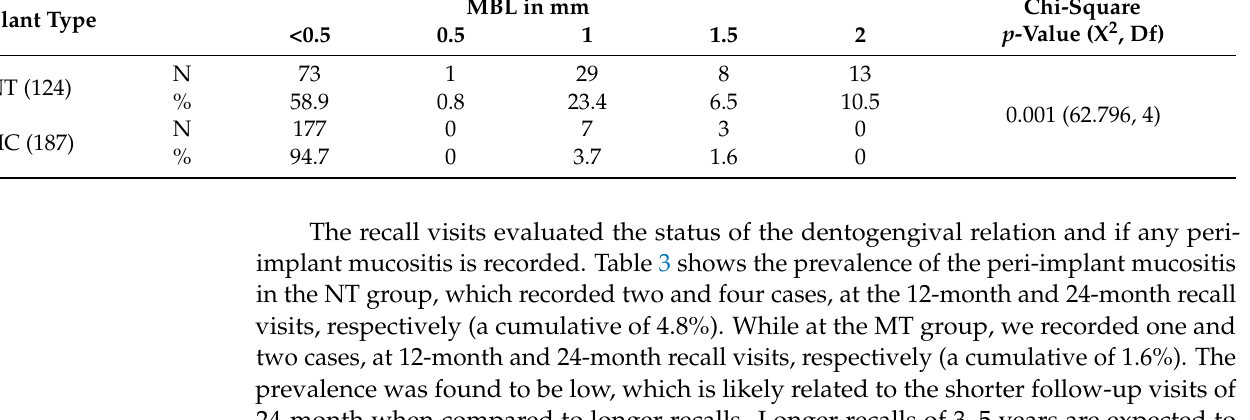
Figure 3. A bar chart presenting the relation of MBL in mm between the two implant systems. The NT bars are showing more MBL when compared to the NT system.